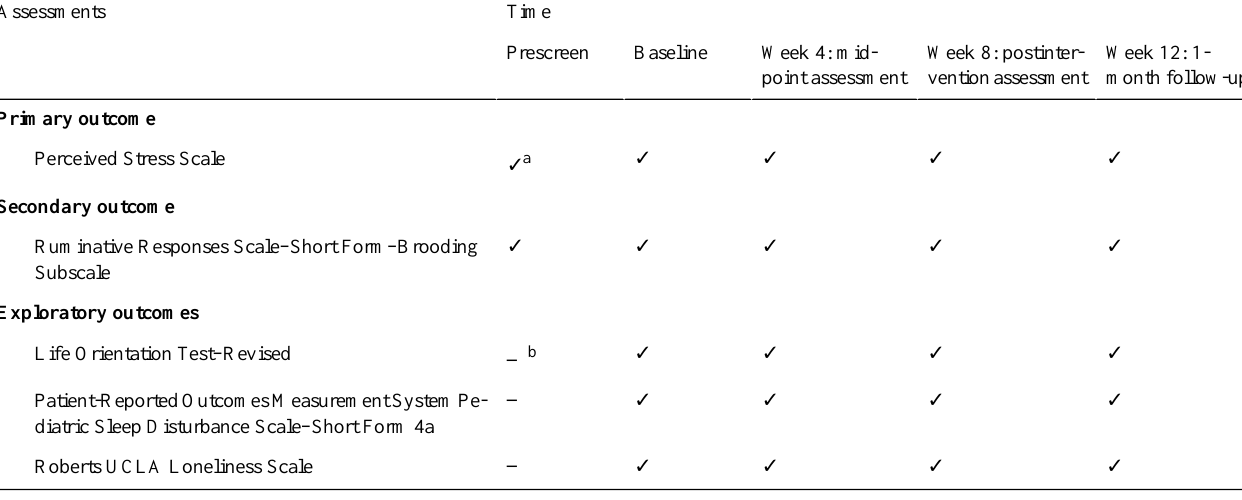
Table 1. Schedule of activities for prescreen, intervention period, and follow-up assessments.